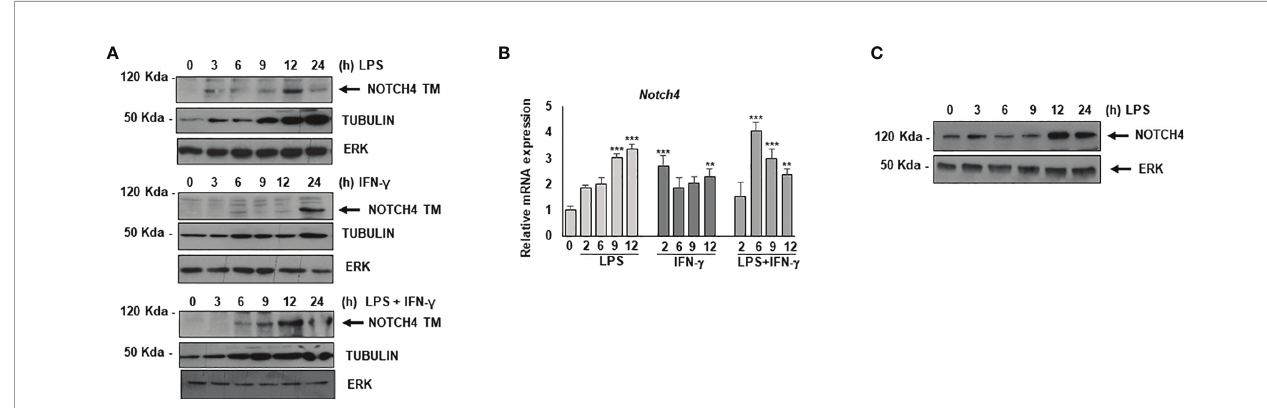
FIGURE 1 | Analysis of NOTCH4 expression after macrophage activation by TLR4 agonists and IFN- g . (A) Western blot analysis for NOTCH4 expression in peritoneal macrophages activated with LPS (100 ng/ml) and/or IFN- g (10 U/ml) for different times. b -tubulin expression was used as a loading reference. The image is representative of three independent experiments. TM mature transmembrane receptors (B) qRT-PCR analysis of Notch4 gene expression in peritoneal murine macrophages activated with LPS in the presence or in the absence of IFN- g for different times. Means ± SD of three independent experiments are shown. One-way ANOVA/Bonferroni ’ s post-tests were performed. Statistical signi fi cance was determined at the level of **p<0.01, ***p<0.001. (C) Western blot analysis of NOTCH4 expression in human monocytes activated with LPS for different times. The image is representative of three independent experiments. ERK expression was used as a loading